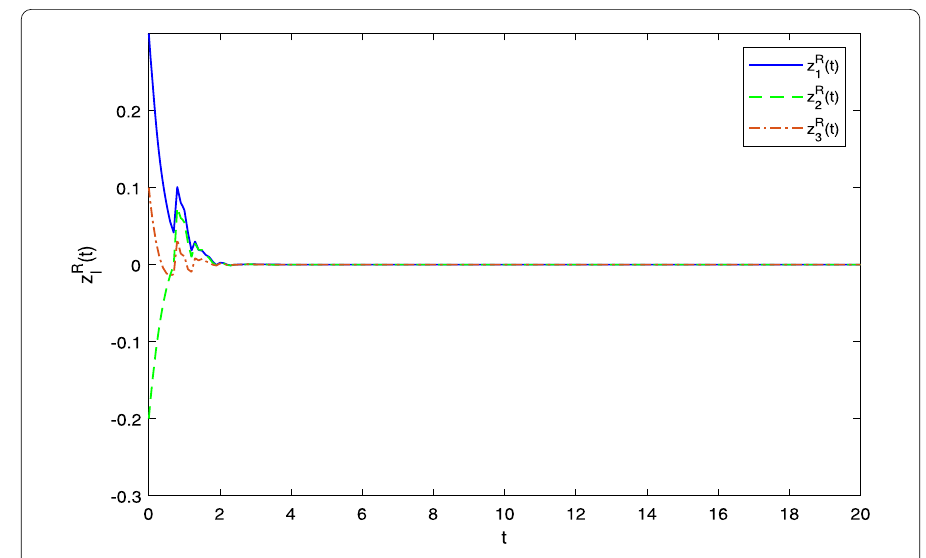
Figure 2 State trajectories of variables z R